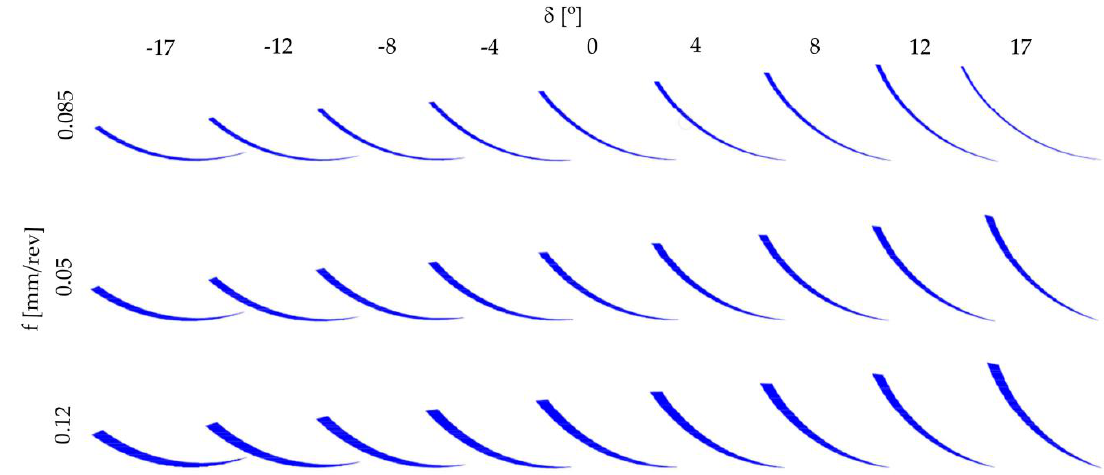
Figure 1. Scheme of forming undeformed chip area A t .